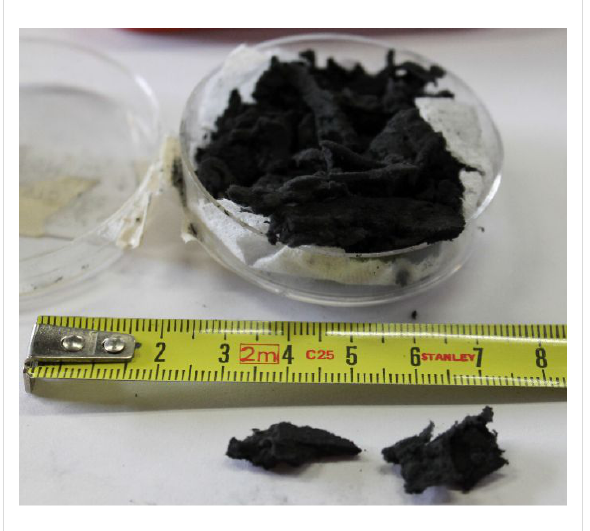
Figure 1: Photograph of a dish containing CNT-sponges, and two cut pieces of few cubic mm.